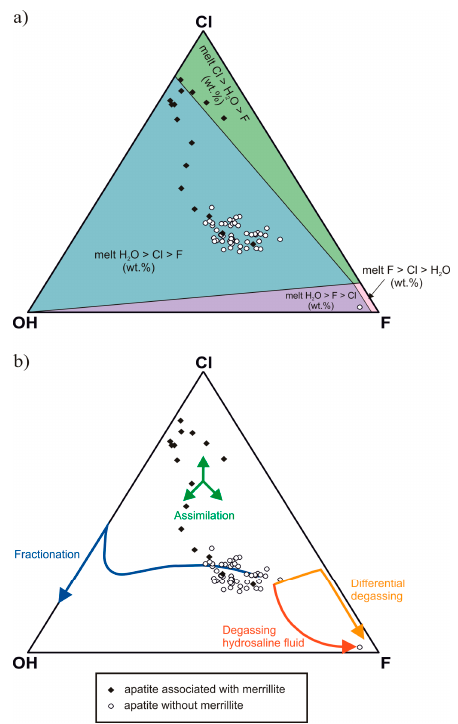
Figure 9. Ternary plots of apatite X-site occupancy (mol %) for NWA 2975 ( a ) relative volatiles content in magma; ( b ) evolutionary trends (after Howarth et al. [39]).